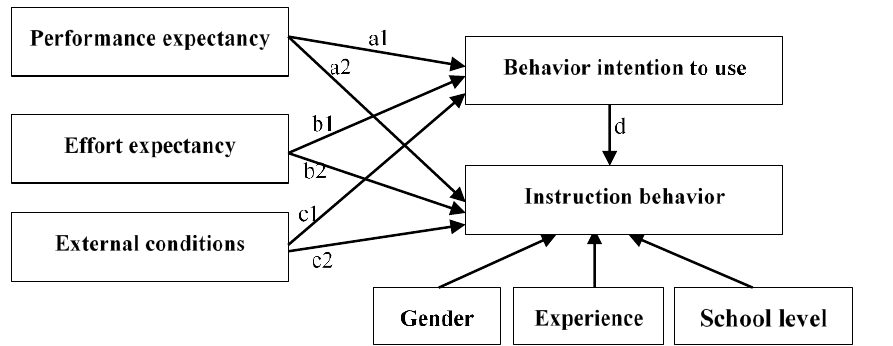
Figure 1. A hypothesized model of the influence of teachers’ performance expectancy, effort expectancy, and external conditions on their instruction behavior.